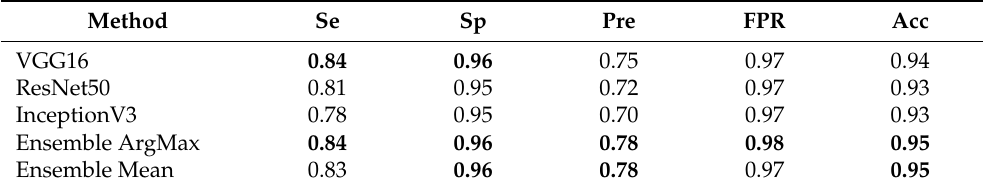
Table 5. Performance metrics for the different classifiers without the previous segmentation of the image when classifying BCC vs. All lesions. Se: Sensitivity, Sp: Specificity, Pre: Precision, FPR: False Positive Rate, Acc: Accuracy. The highest values are shown in bold numbers.